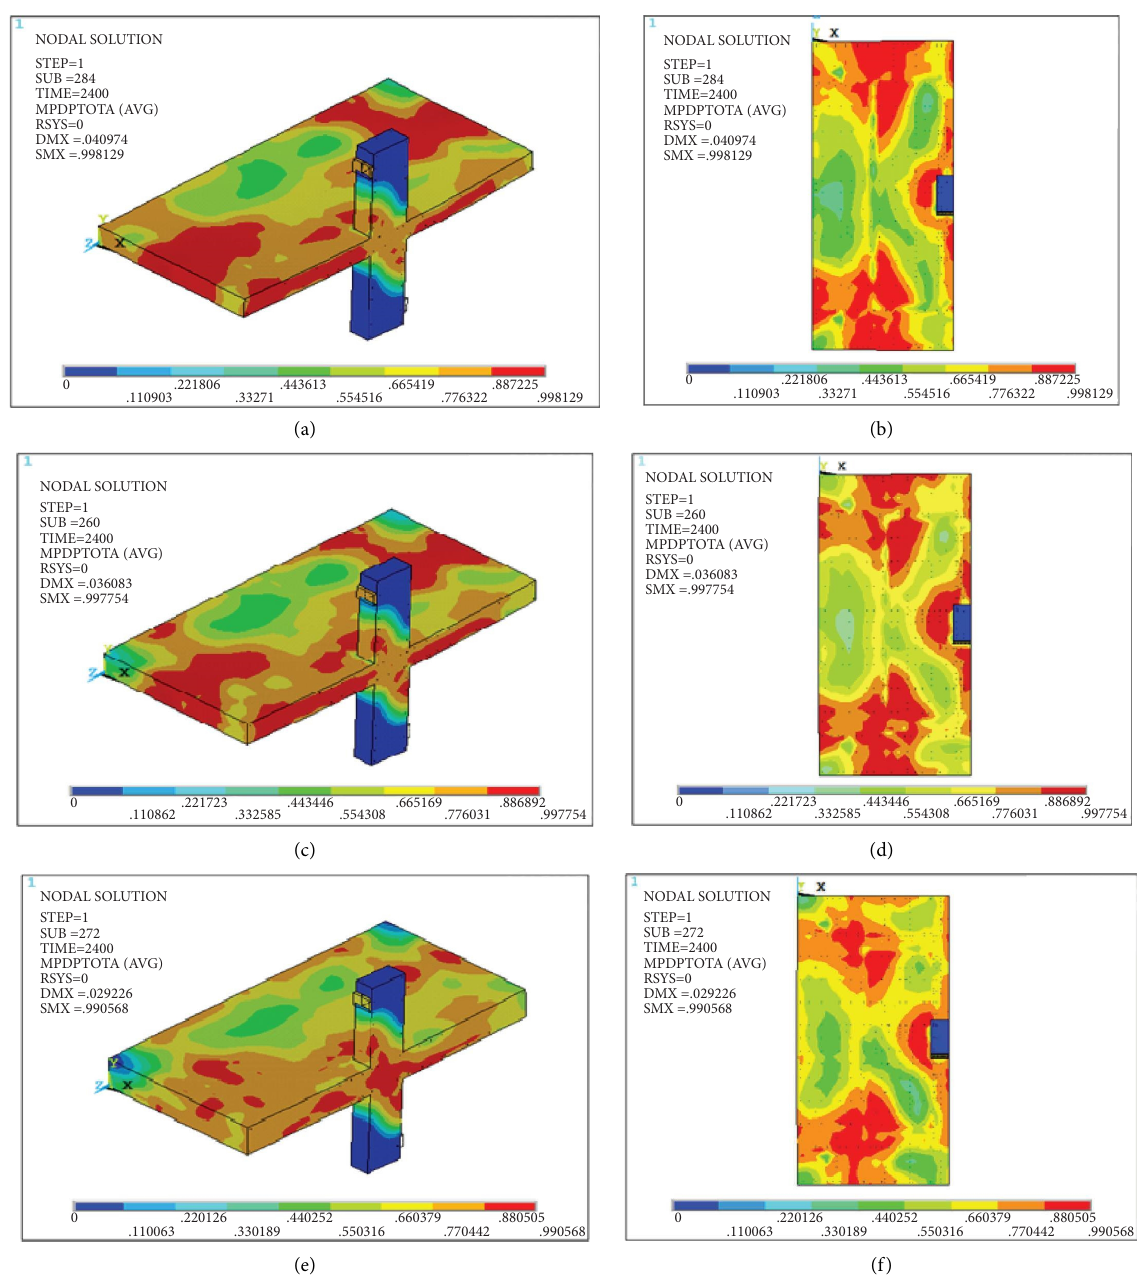
Figure 39: Concrete damage of specimens with varying slab thickness. (a) Specimen 150-45-1-ALL Bs-2400. (b) Bottom surface. (c) Specimen 175-45-1-ALL Bs-2400. (d) Bottom surface. (e) Specimen 250-45-1-ALL Bs-2400. (f) Bottom